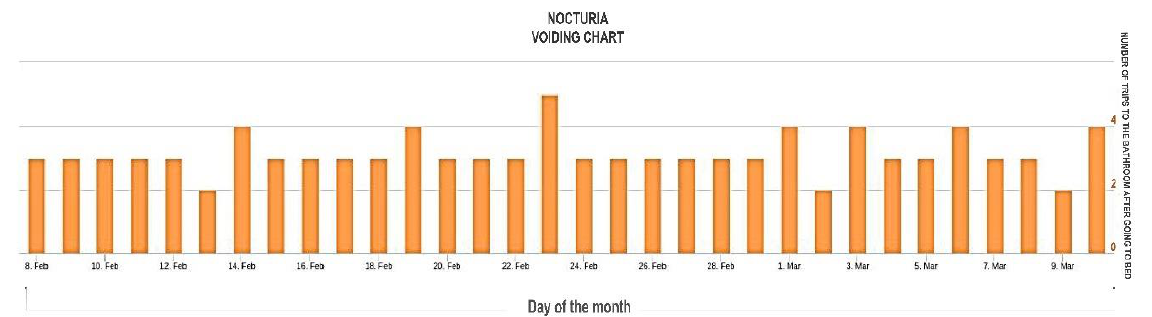
Figure 7. Daily nocturnal urination events.